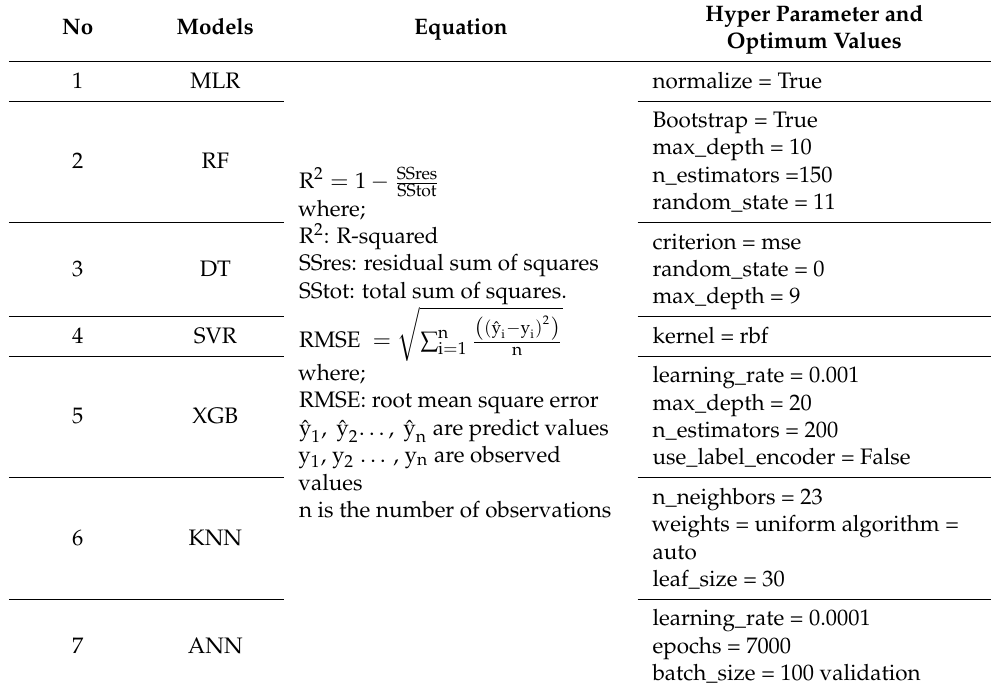
Table 1. Different ML models, general equation and Hyperparameter